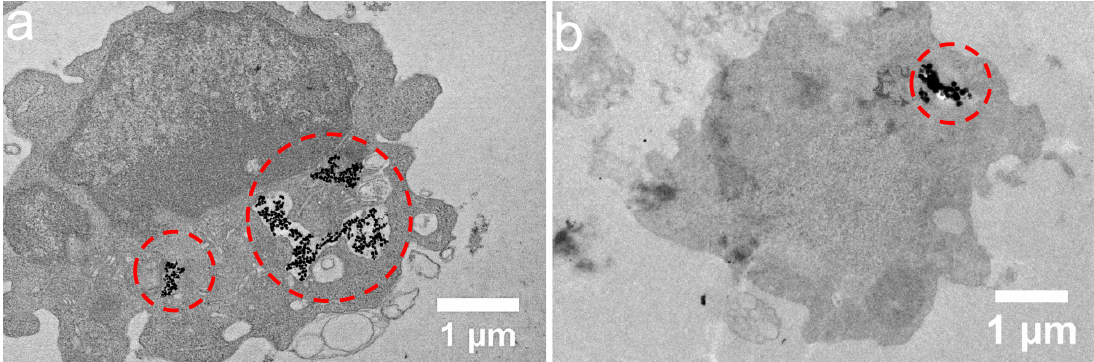
Figure 8. Bright-field TEM images of macrophages with 40 nm ( a ) and 85 nm ( b ) CNCs internalized (dashed circles) by likely endocytosis or engulfed inside endosomes.